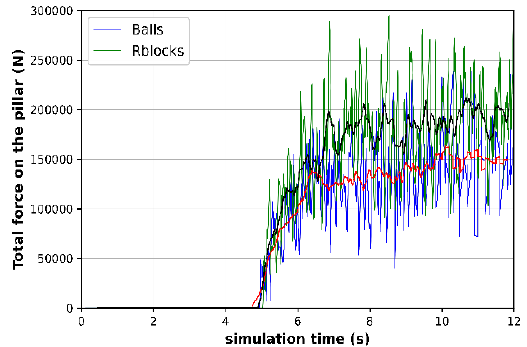
Fig. 6.: Total force applied by particles on a pillar versus simulation time. The black curve shows a moving average window (filter) with k = 10 for r-blocks ant the red one for